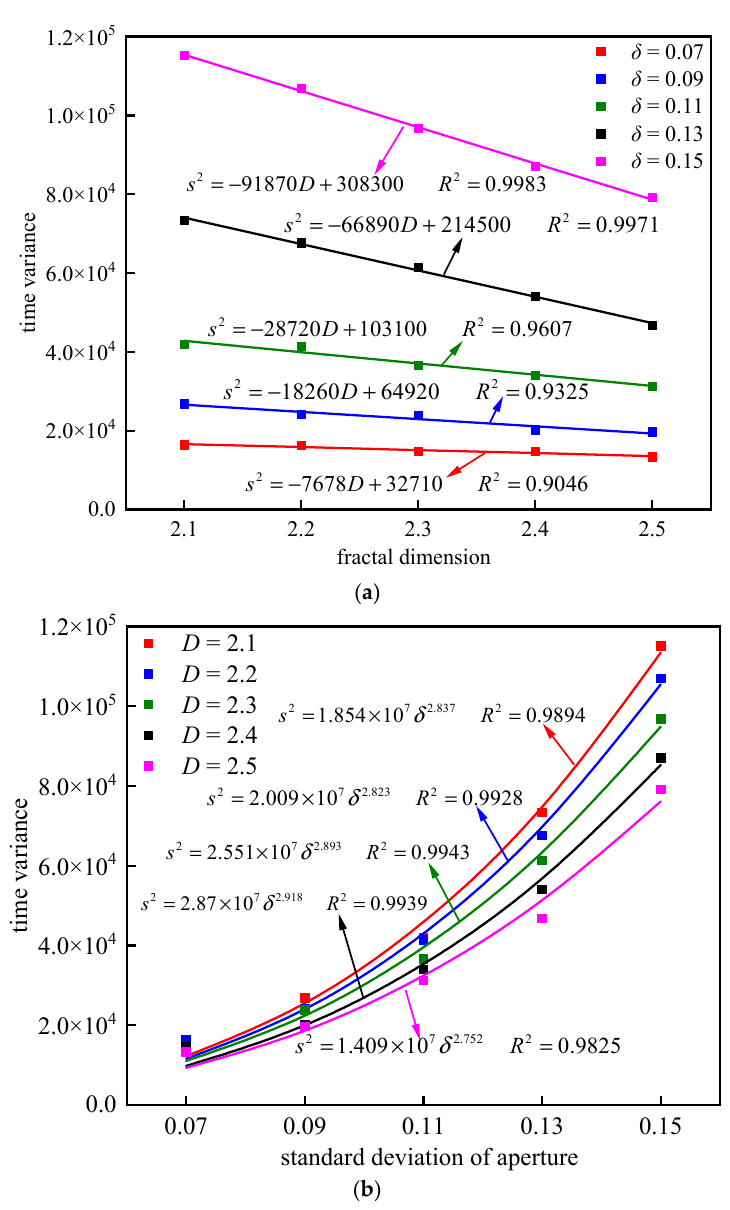
Figure 8. ( a ) Time variance versus fractal dimension; ( b ) time variance versus standard deviation of aperture.